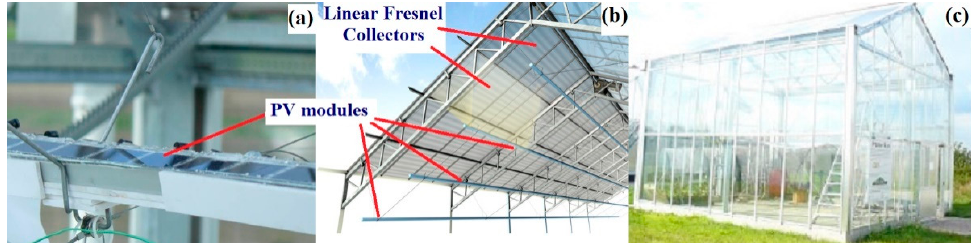
Figure 10. ( a ) The PV modules of the system; ( b ) the linear Fresnel collectors of the system; ( c ) the Fresnel greenhouse (The Netherlands). Reprinted with permission from Ref. [103]. Copyright 2011